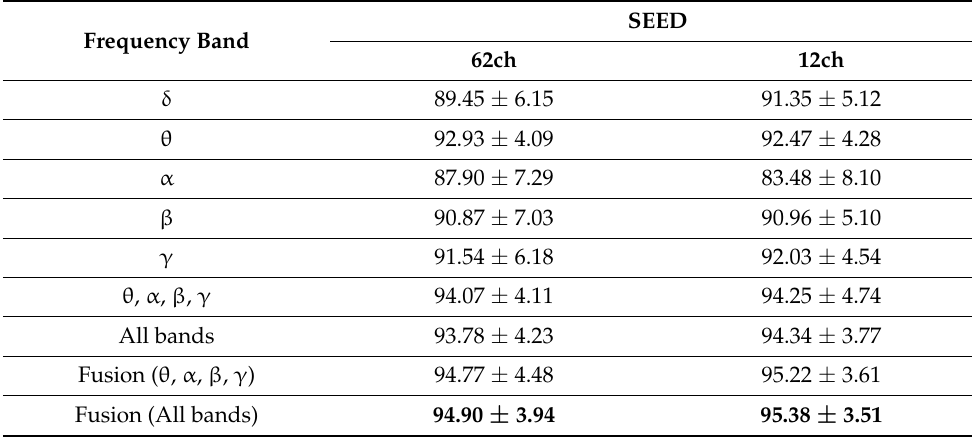
Table 2. Channel selection and band performance (ACC ±